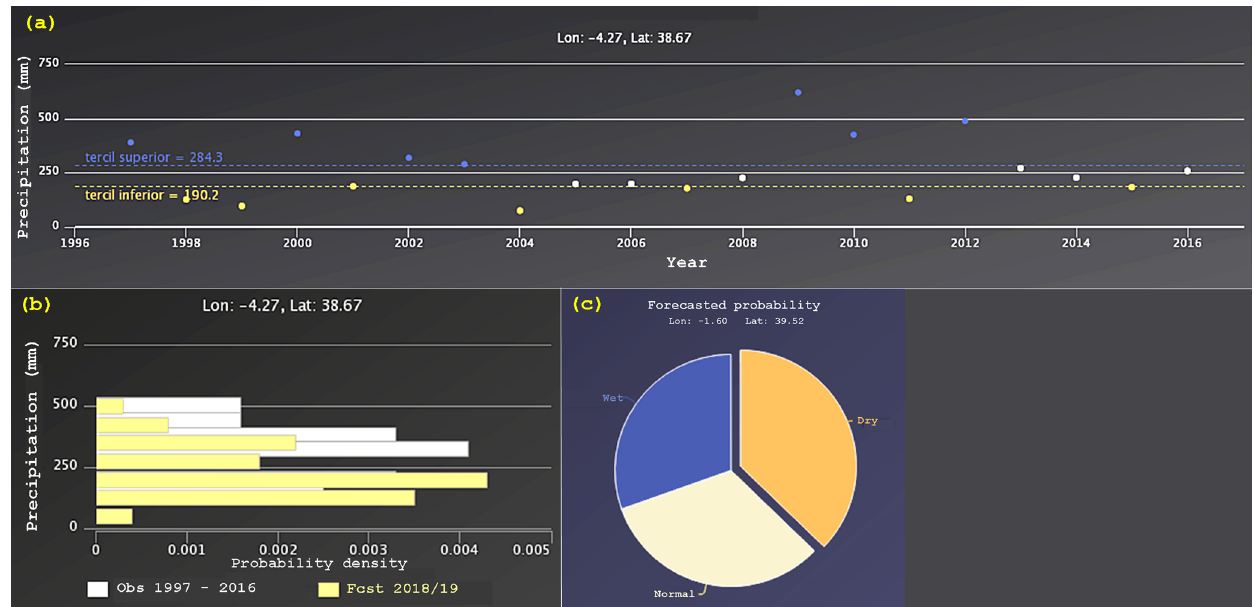
Figure 6. Graphs in the bottom panel in the forecasting view. (a) Historical evolution of winter total inflow/precipitation over the hindcast period. Two horizontal lines indicate the two terciles allowing to classify the different winters as dry/normal/wet, and each data value is plotted accordingly in blue/beige/orange. (b) Two histograms corresponding to observed (white) and forecasted (yellow) pdf for winter inflow/precipitation, respectively. (c) Pie chart in graph displaying forecasted probability for each category: wet (blue), normal (beige) and dry (orange). Each sector surface is proportional to the category